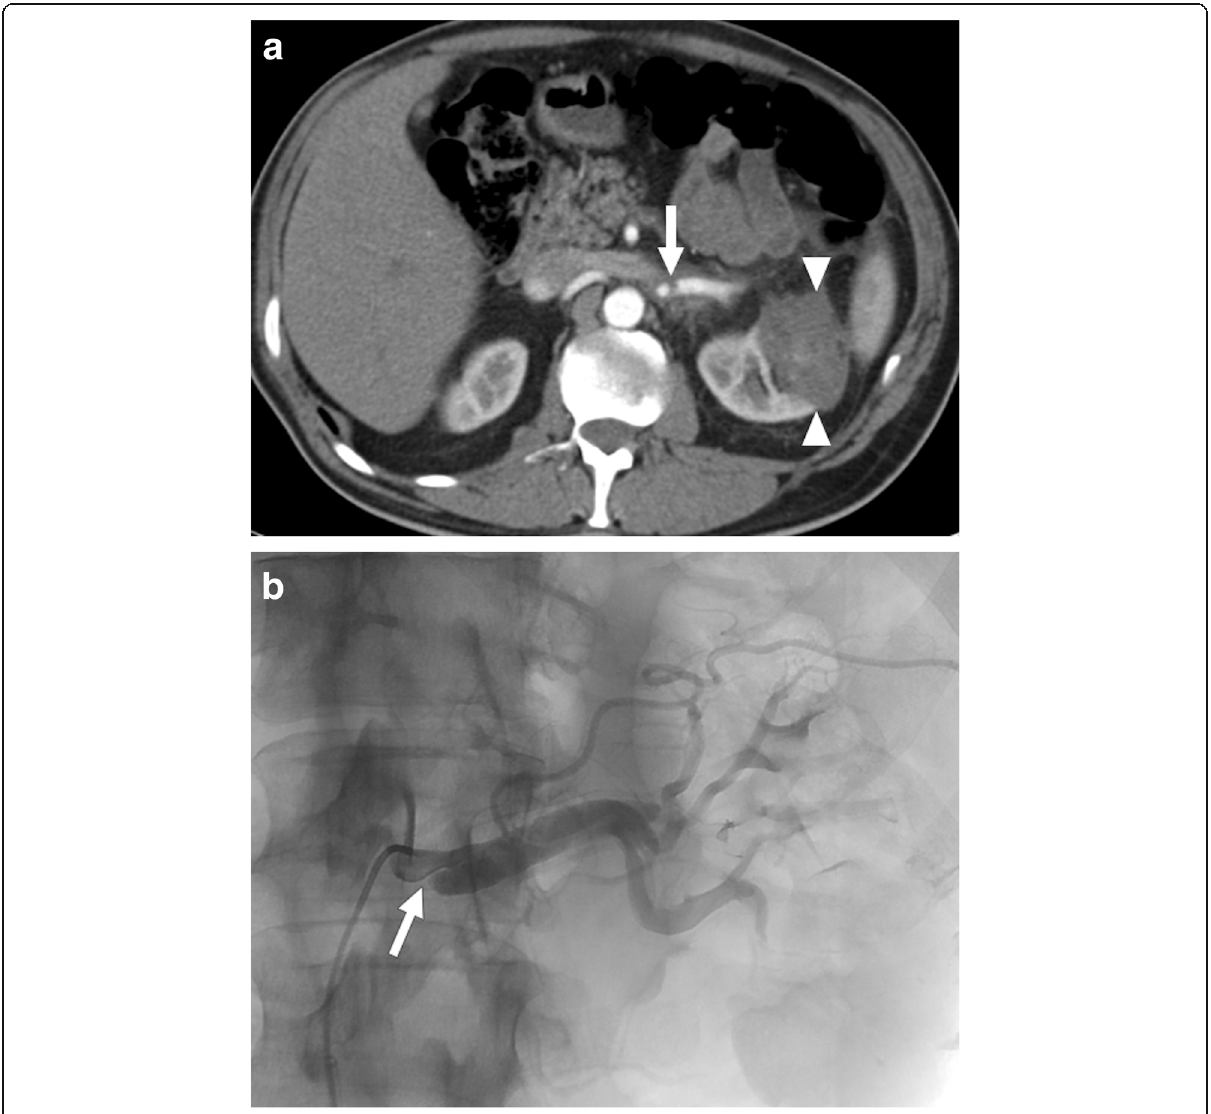
Fig. 12 Spontaneous renal artery dissection. 44-year-old male with known Marfan syndrome presented to ED with acute onset severe left flank pain and massive hematuria. US examination showed enlarged left kidney with decreased color Doppler signal in the upper pole of the kidney parenchyma. a Arterial phase CT angiography image showed flap in the proximal third of the left renal artery (arrow). Also, note is made of large infarct in the upper pole parenchyma (arrowheads). b Emergent catheter angiography confirmed the presence of the intimal flap